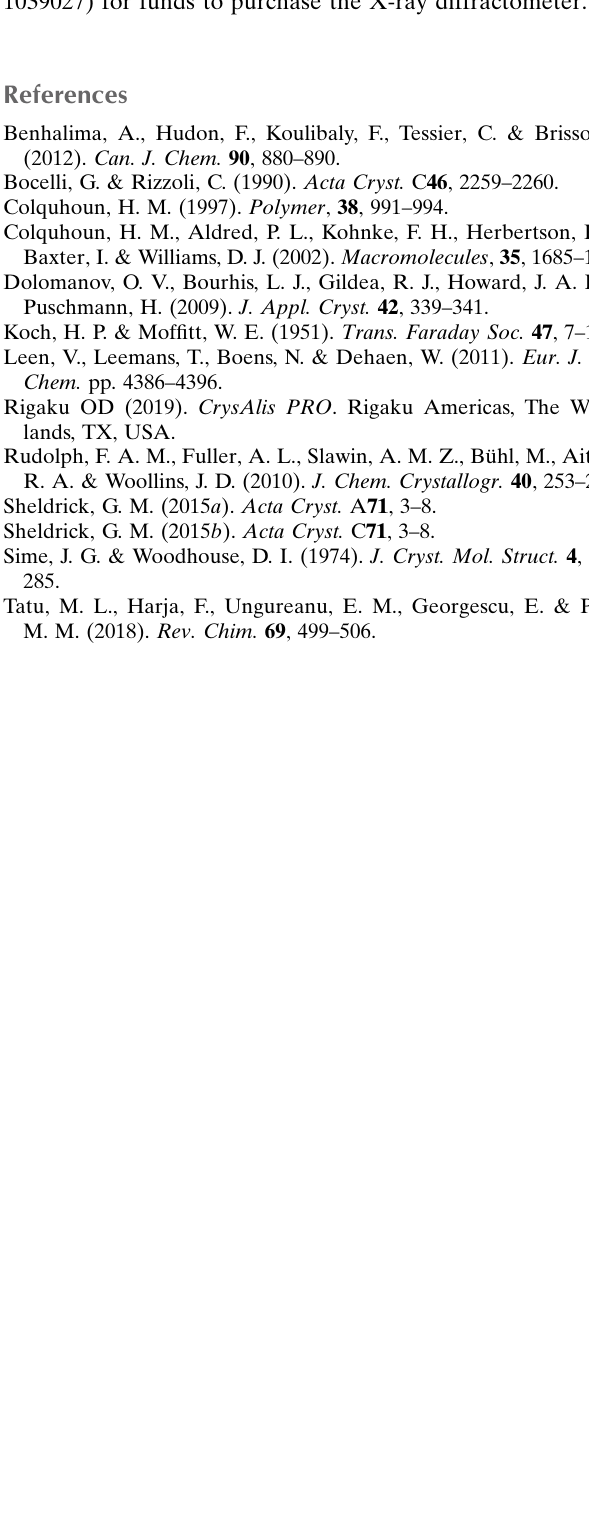
Table 3 Experimental details. Crystal data Chemical